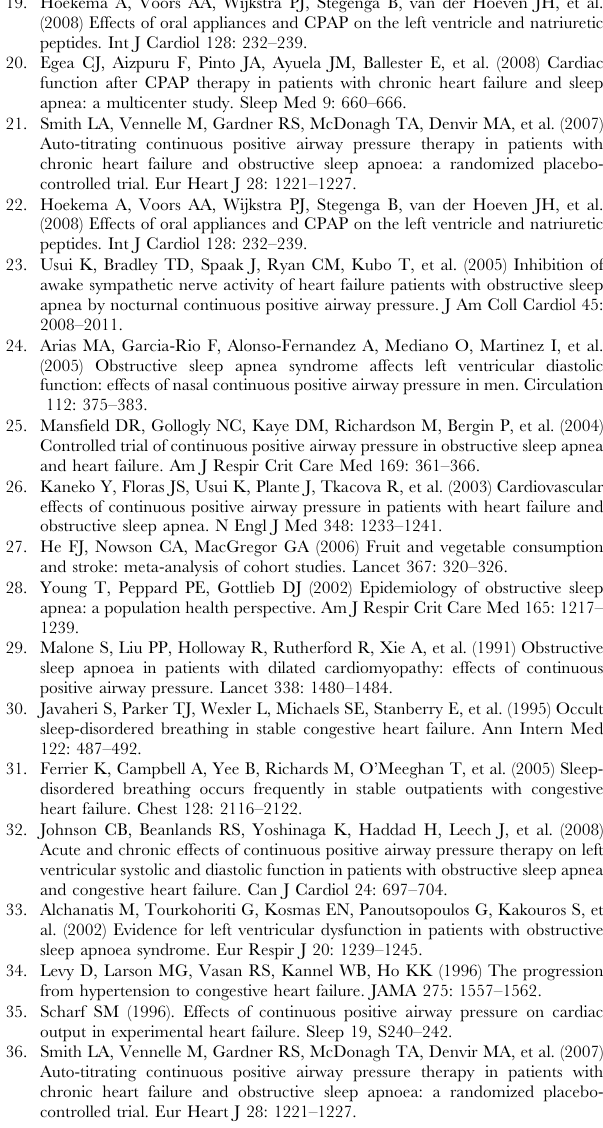
Figure S4 Forest plot presenting the meta-analysis for